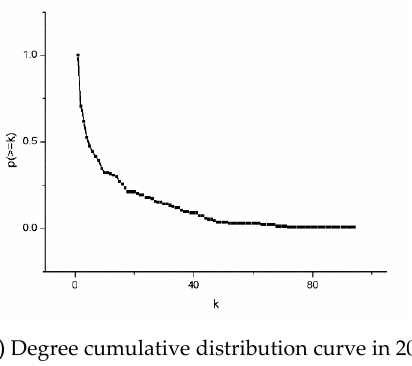
Figure 3. Degree cumulative distribution curve during 2014–2018. Figure 3 contains five graphs, which are arranged by year as: ( a ) 2014, ( b ) 2015, ( c ) 2016, ( d ) 2017, ( e ) 2018. Without changing the network density, the author cooperation network is composed of a small number of core authors and a large number of non-core authors. The cooperation relationship extended by the core authors constitutes the framework of the whole network. Knowledge exchange in the network is mostly accomplished through the transformation between the main paths in the framework. Meanwhile, among the biology and chemistry papers, the core authors have not changed much in recent years and are likely to remain stable in the next few years. Only the ranking order of